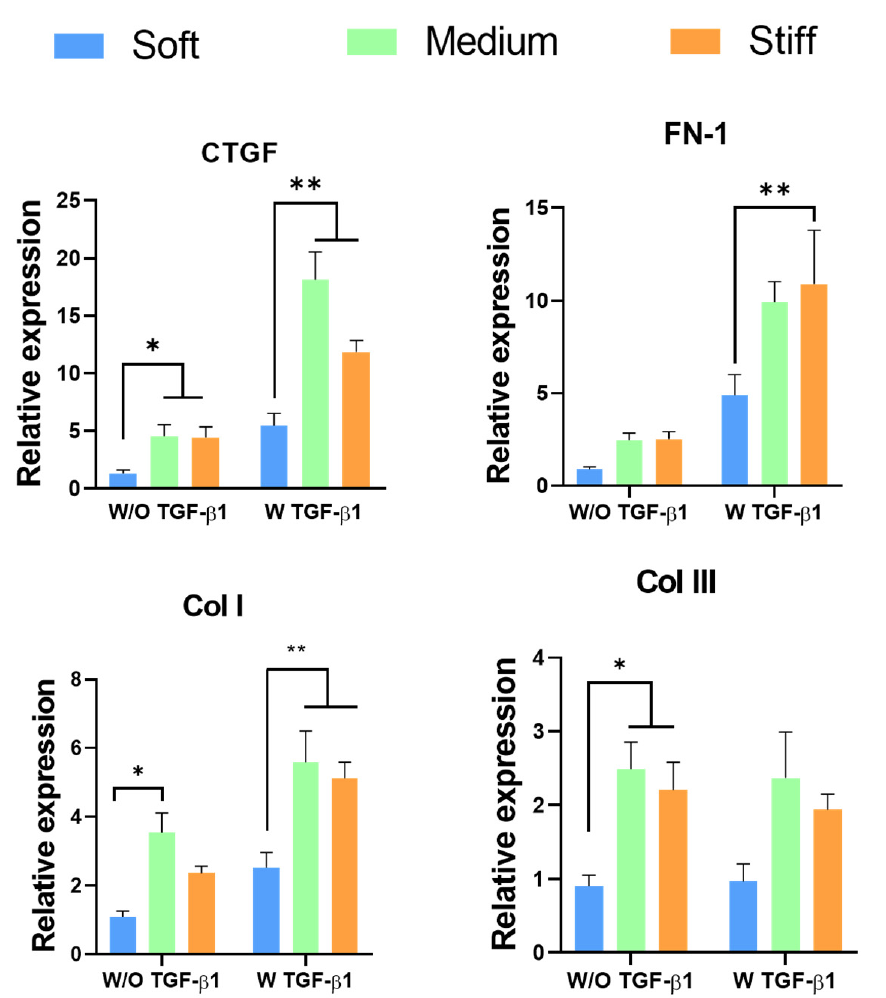
Figure 4. Effect of increasing GelMA hydrogel stiffness on connective tissue growth factor (CTGF), fibronectin I (FN), collagen I (Col I) and collagen III (Col III) expression. * p < 0.05 compared to the soft GelMA hydrogel in the absence of TGF- β 1; ** p < 0.05 compared to the soft GelMA hydrogel in the presence of TGF- β